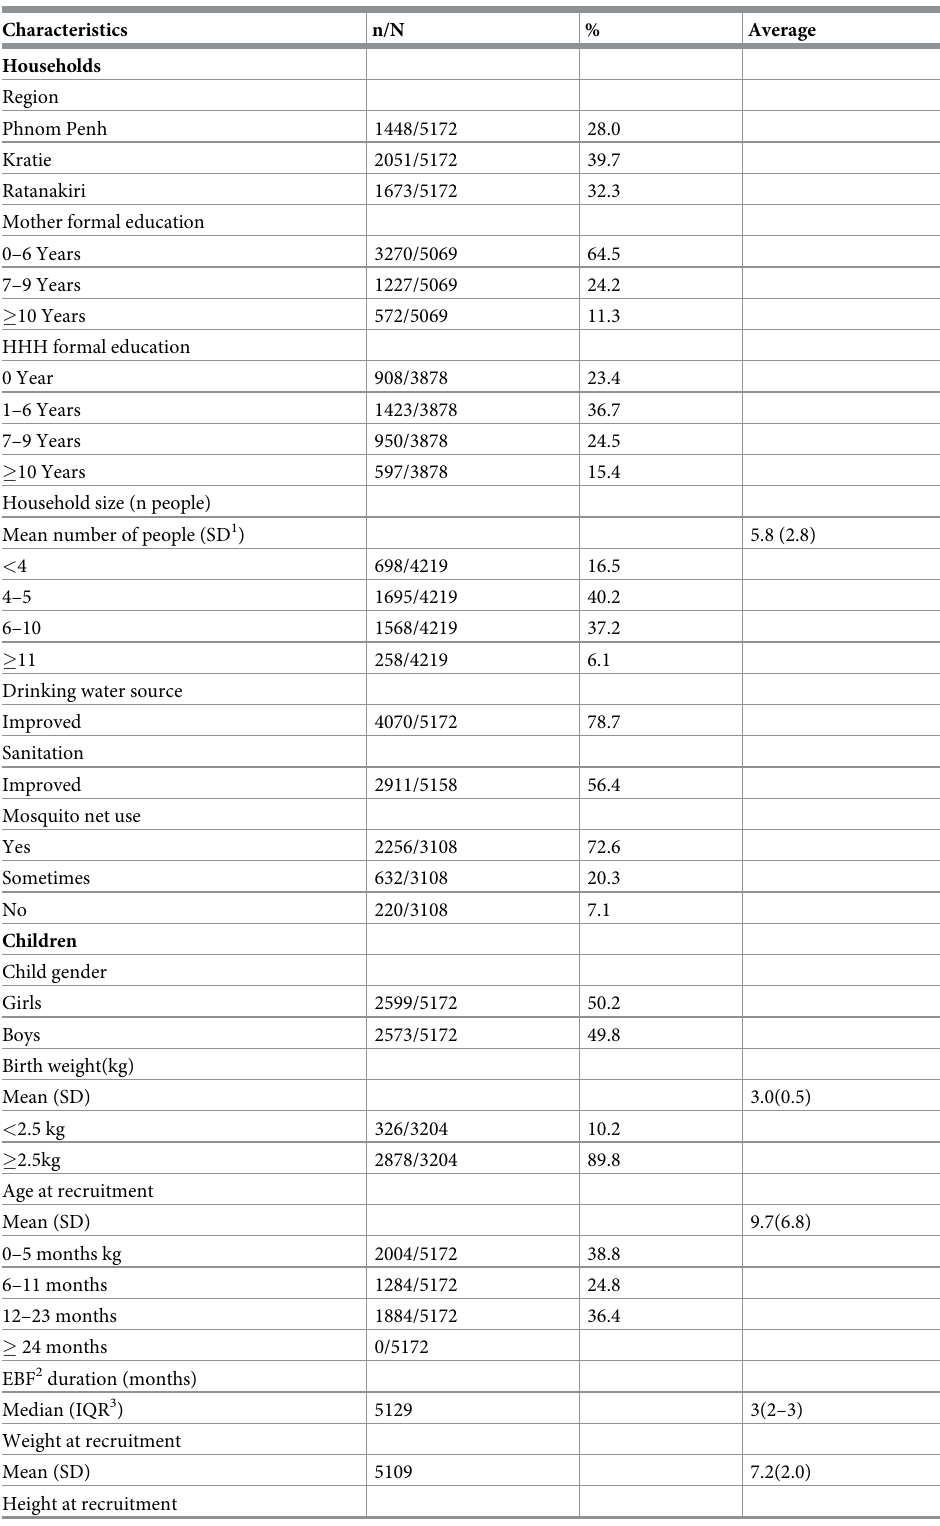
Table 1. Households and children